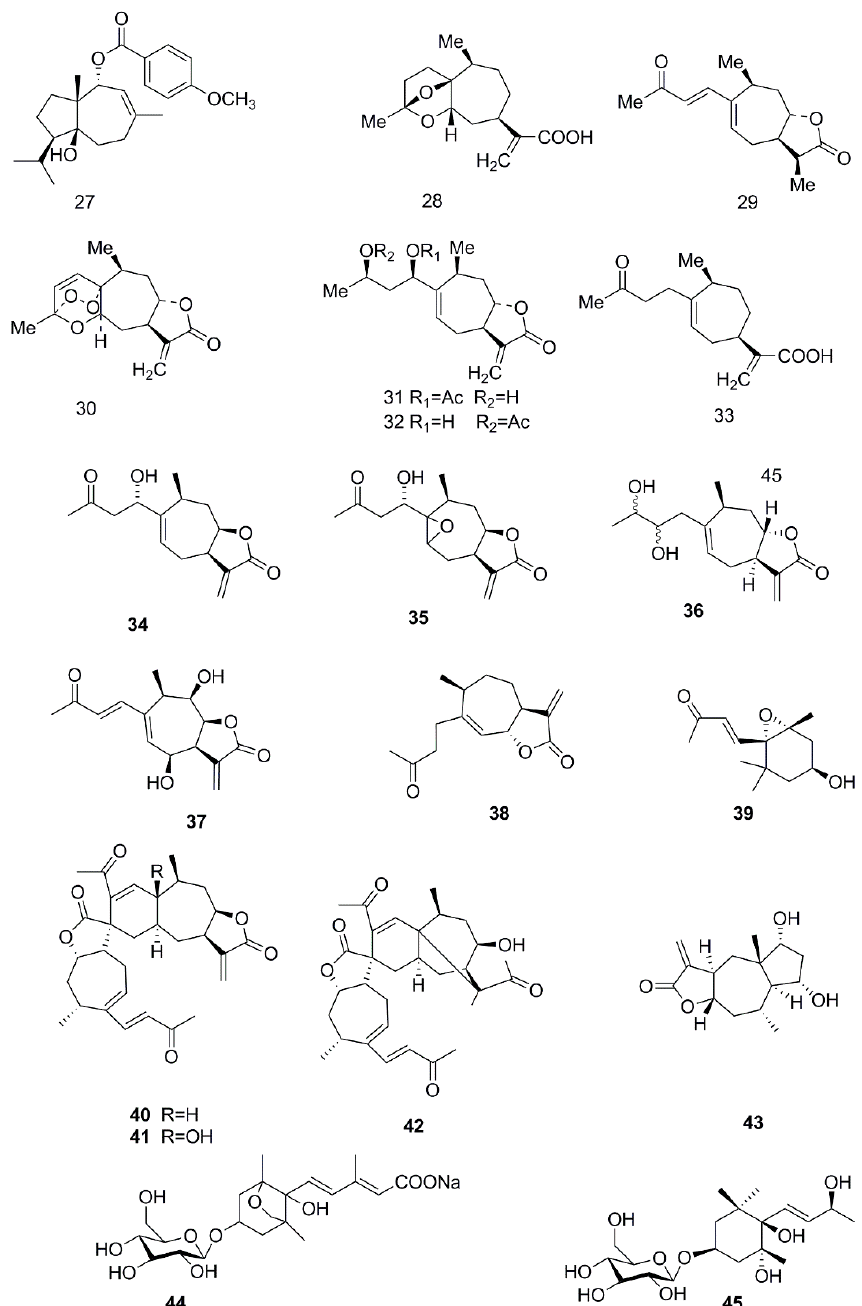
Figure 2. Chemical structures of the sesquiterpenoids in X. strumarium.